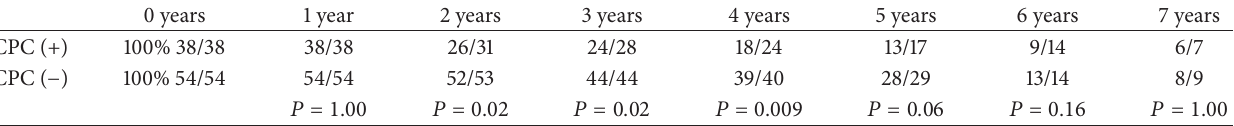
Table 5: Kaplan Meyer plot for men without biochemical failure with time after radical prostatectomy.